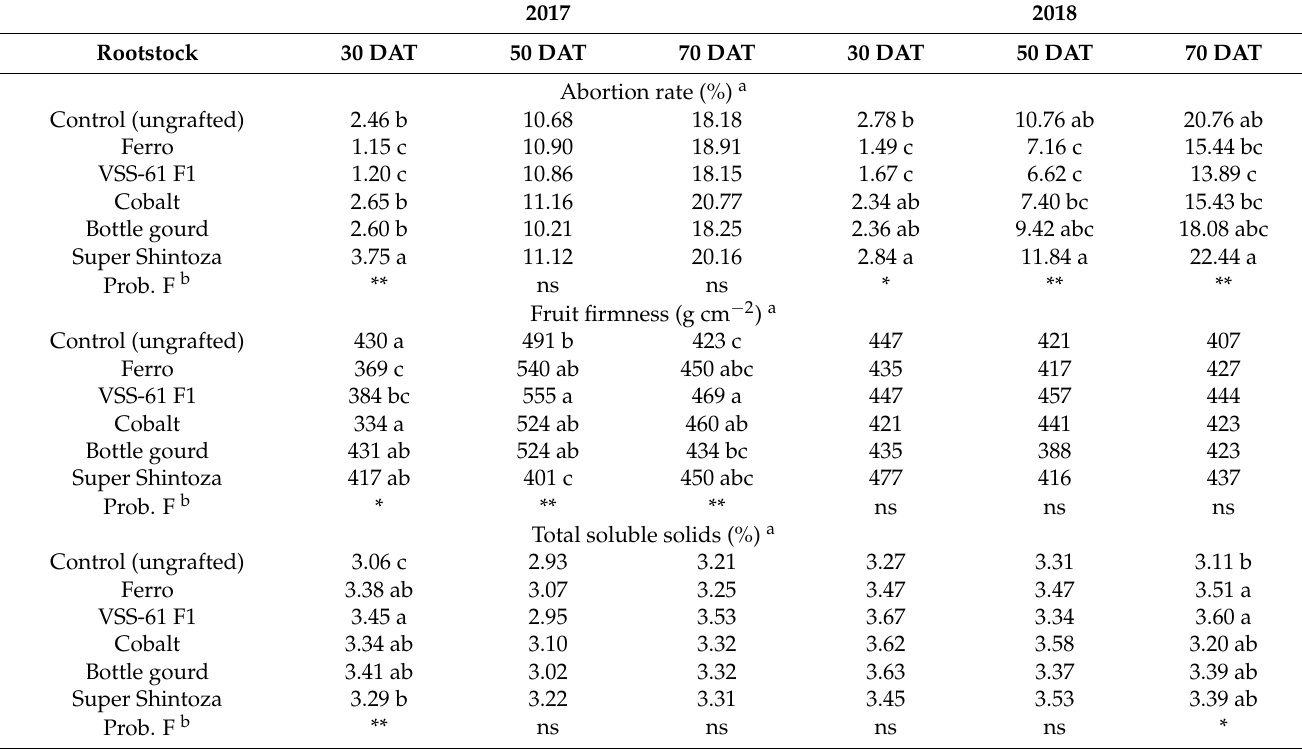
Table 3. Means of the abortion rate per plant, fruit firmness, and total soluble solids of Gianco F1 cucumber plants, grafted onto five cucurbit rootstocks and the ungrafted control, under heat and salinity stresses in the 2017 and 2018 seasons. Details on the measurement of the traits presented are provided in the Material and Methods